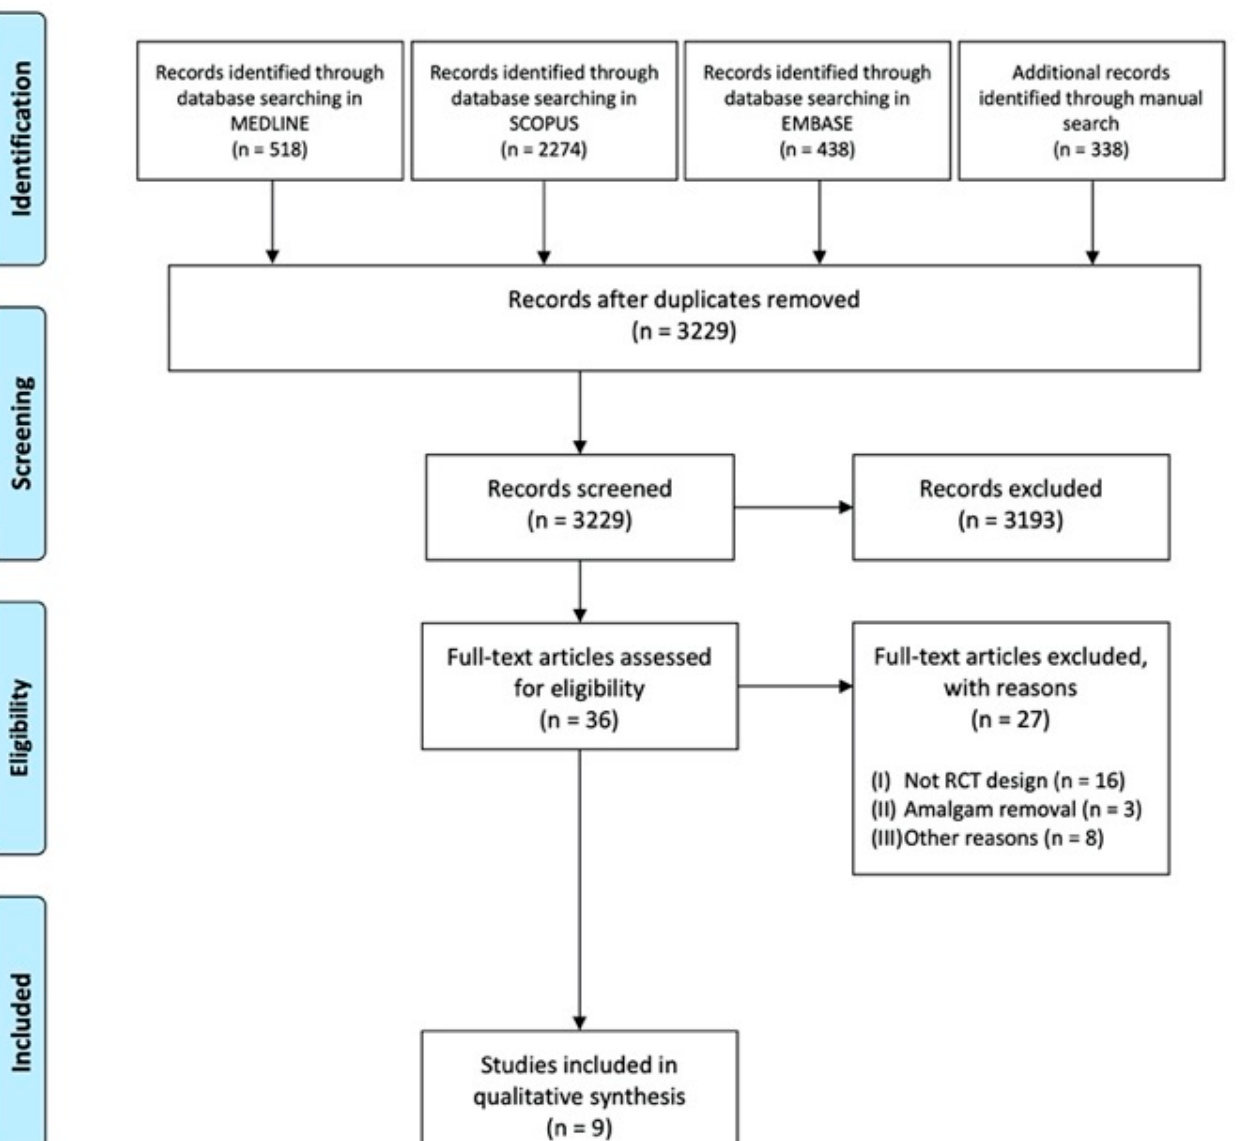
Figure 2. Preferred Reporting Items for Systematic Reviews and Meta-Analyses (PRISMA) 2009 flow diagram for study selection [34].